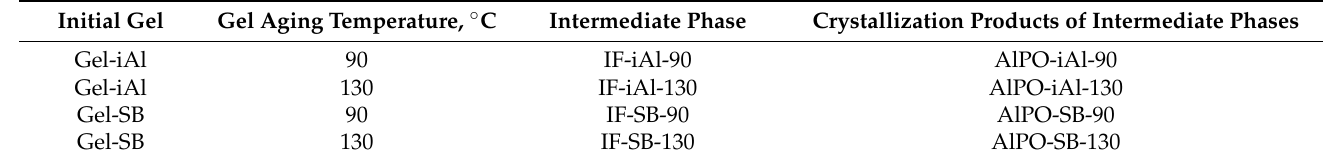
Table 1. Explanation of symbols aluminophosphates and their crystallization products. Initial Gel Gel Aging Temperature, ◦